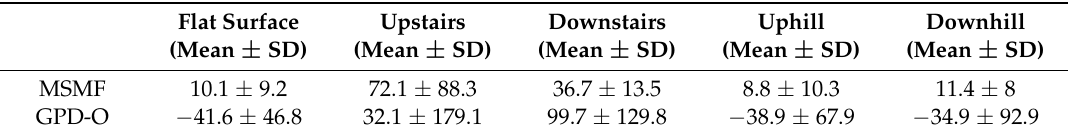
Table 4. Timing error in IC event for MSMF and GPD-O algorithms across different terrains (with respect to push switch).